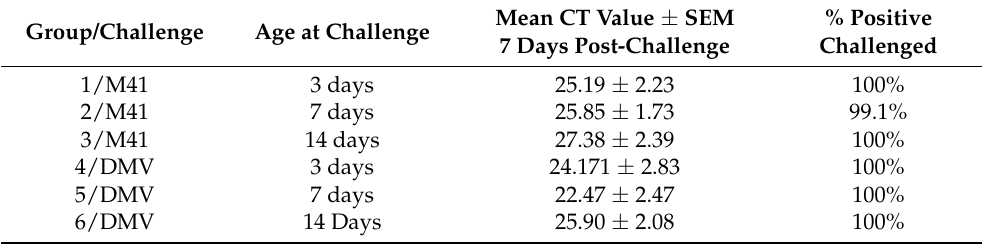
Table 2. Post-Challenge Viral Load as Measured by qRT-PCR.